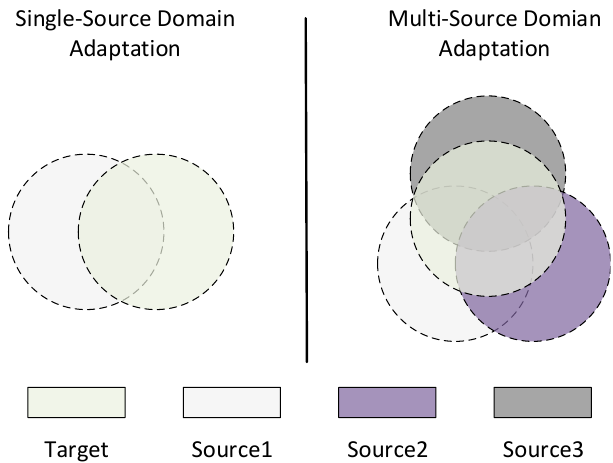
Figure 5. Single-source domain adaptation and multi-source domain